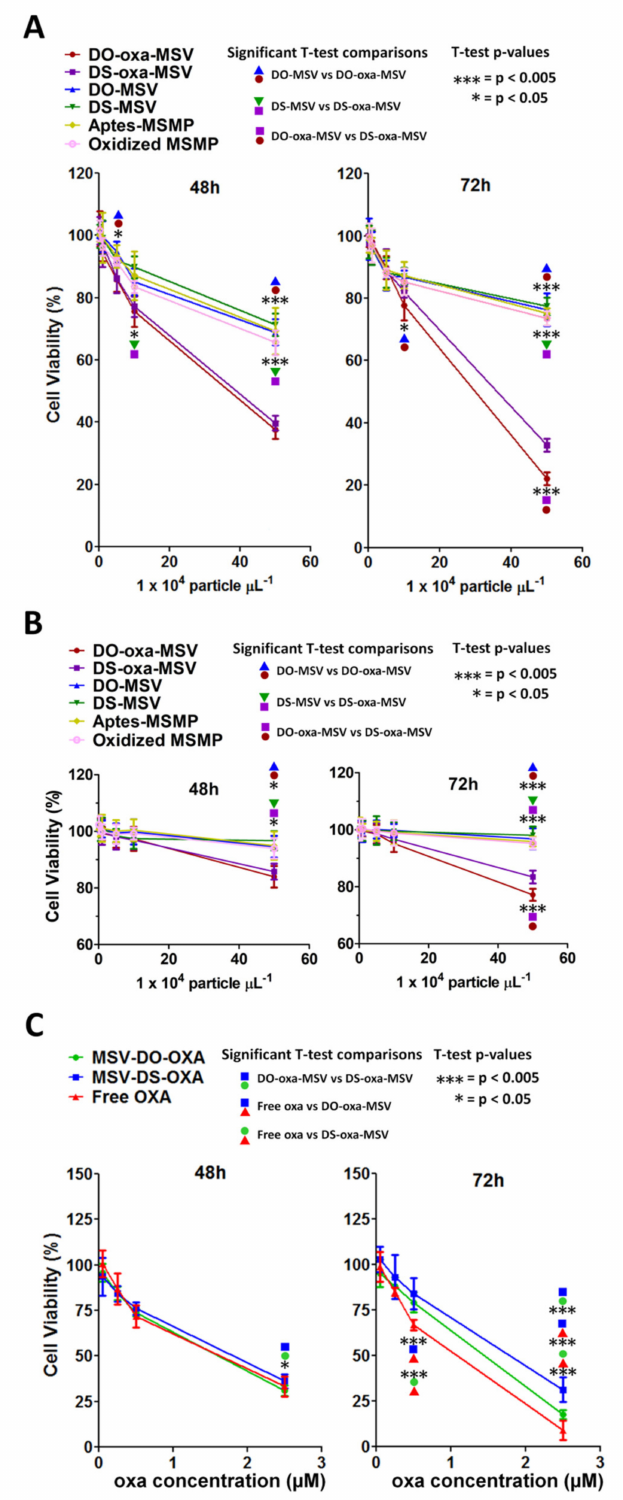
Figure 9. Cell viability e ff ects of MSVs. MTT assay at 48 and 72 h in ( A ) HCT-116 and ( B ) HUVEC incubated with di ff erent MSVs and empty S1MPs with respect to particle concentration; ( C ) MTT assay at 48 and 72 h in HCT-116 incubated with MSVs and free oxa with respect to oxa concentration. Experiments were performed in three independent replicates. Error bars represent standard deviations. Statistical significance was calculated by one-way two-tailed t